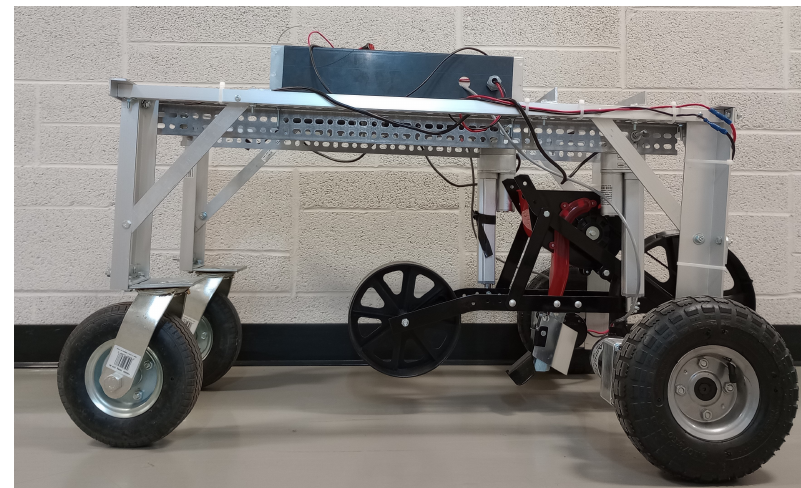
Figure 1. Agricultural robot developed at the University of Quebec at Trois-Rivières.